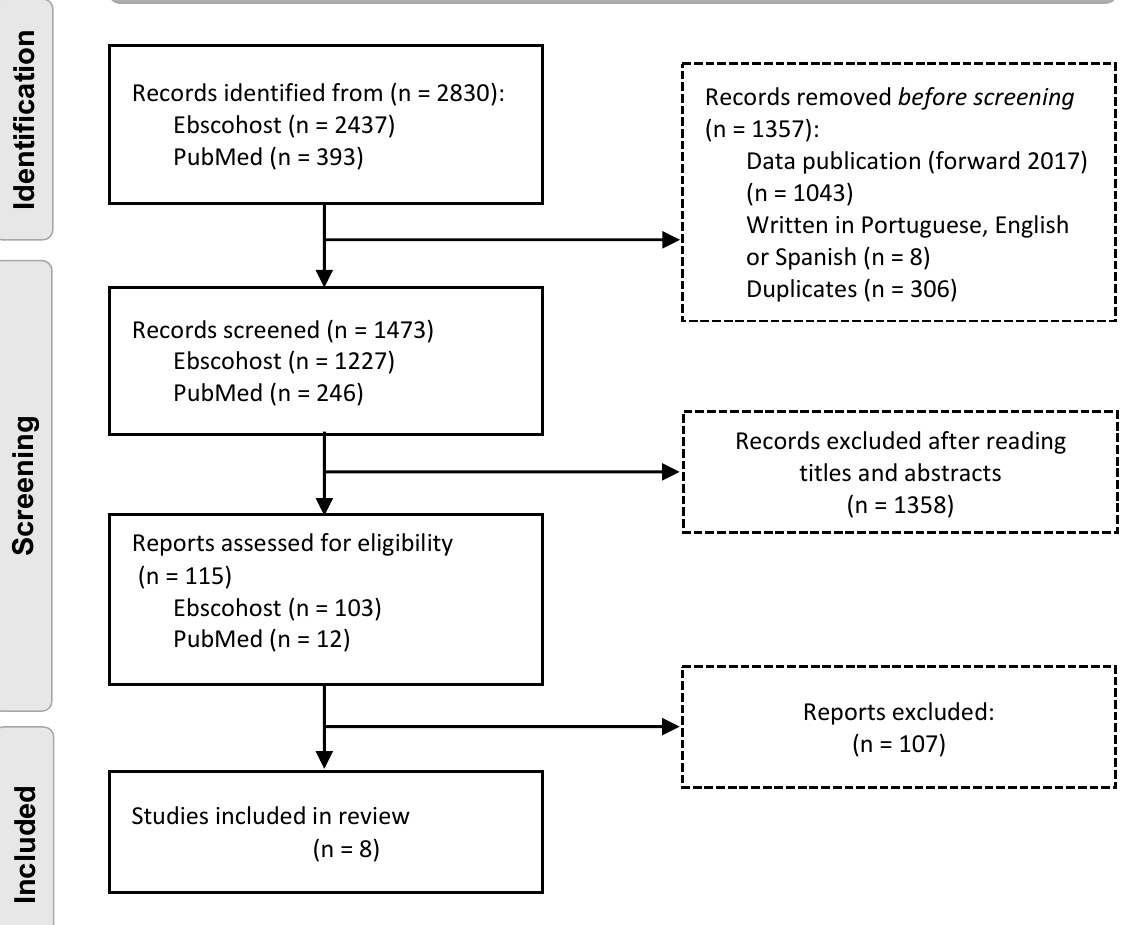
Figure 1. Study flow diagram according to the PRISMA.